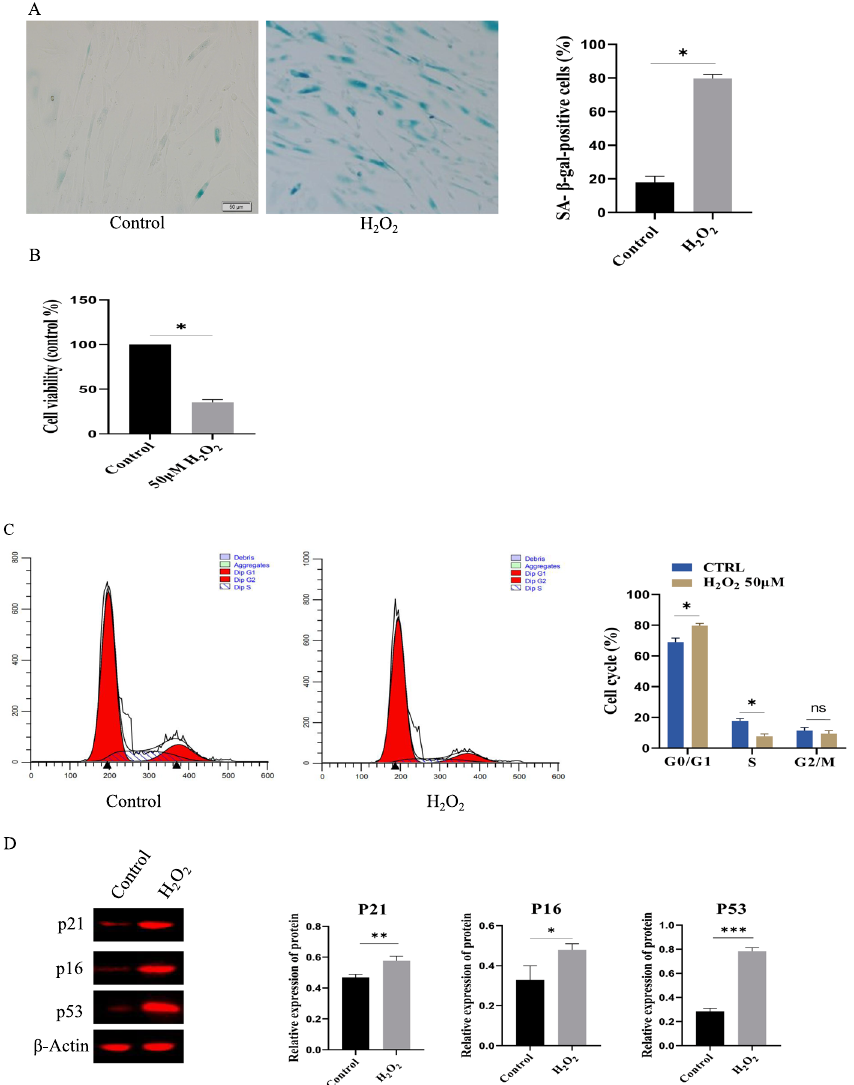
Fig. 1 Establishment of Ad-MSCs senescence model by 50 μM H 2 O 2 treatment. A Percentage of Sa-β-gal-positive cells were significantly decreased under H 2 O 2 treatment, Scale bar, 20 μm. n replicates . B H 2 O 2 (50 μM) treatment inhibited the cell proliferation of Ad-MSCs. C The effect of H 2 O 2 (50 μM) treatment on cell cycle phase by Flow cytometry analyses, n P16 and P53 was down-regulated under H 2 O 2